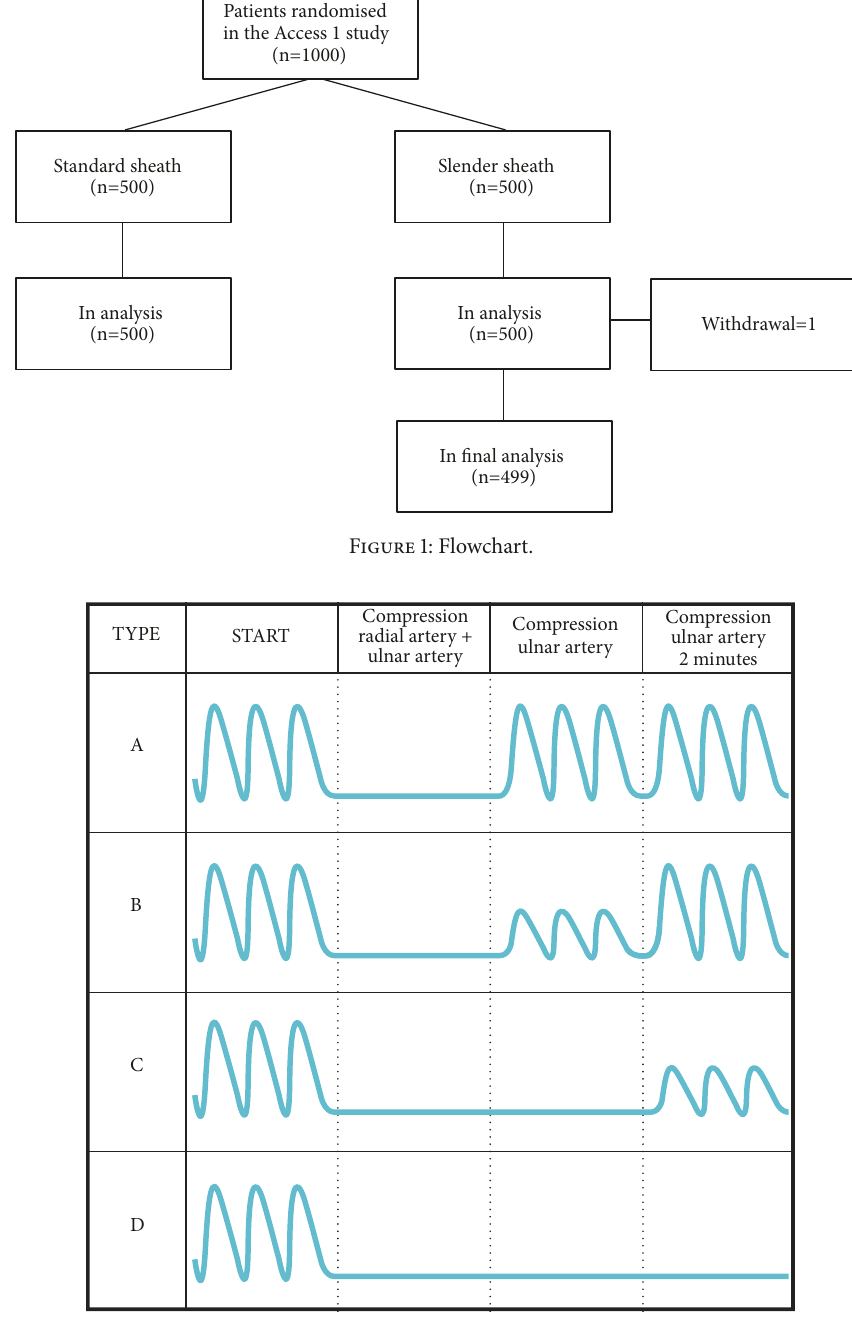
Figure 2: Reverse Barbeau test. Type A-D according to pulse oximetry findings after removal of the TR band at compression of a.radialis and a.ulnaris, or a.ulnaris